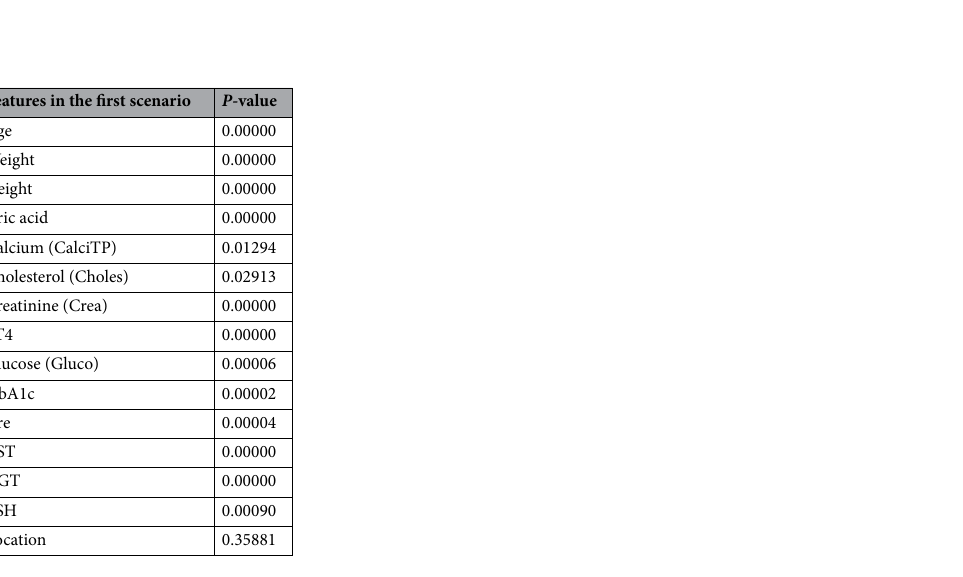
Table 7. The relationship among various features and the outcome in the first